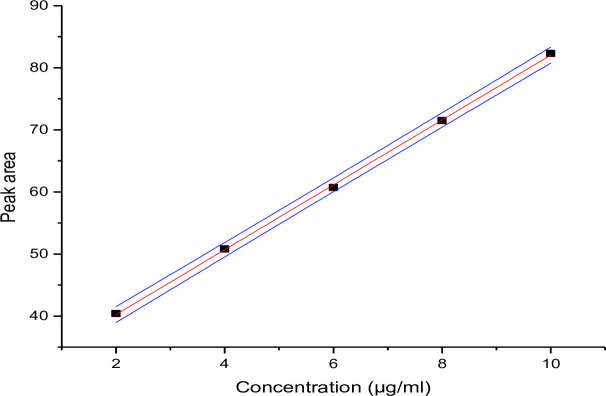
Calibration curve of trimethoprim.